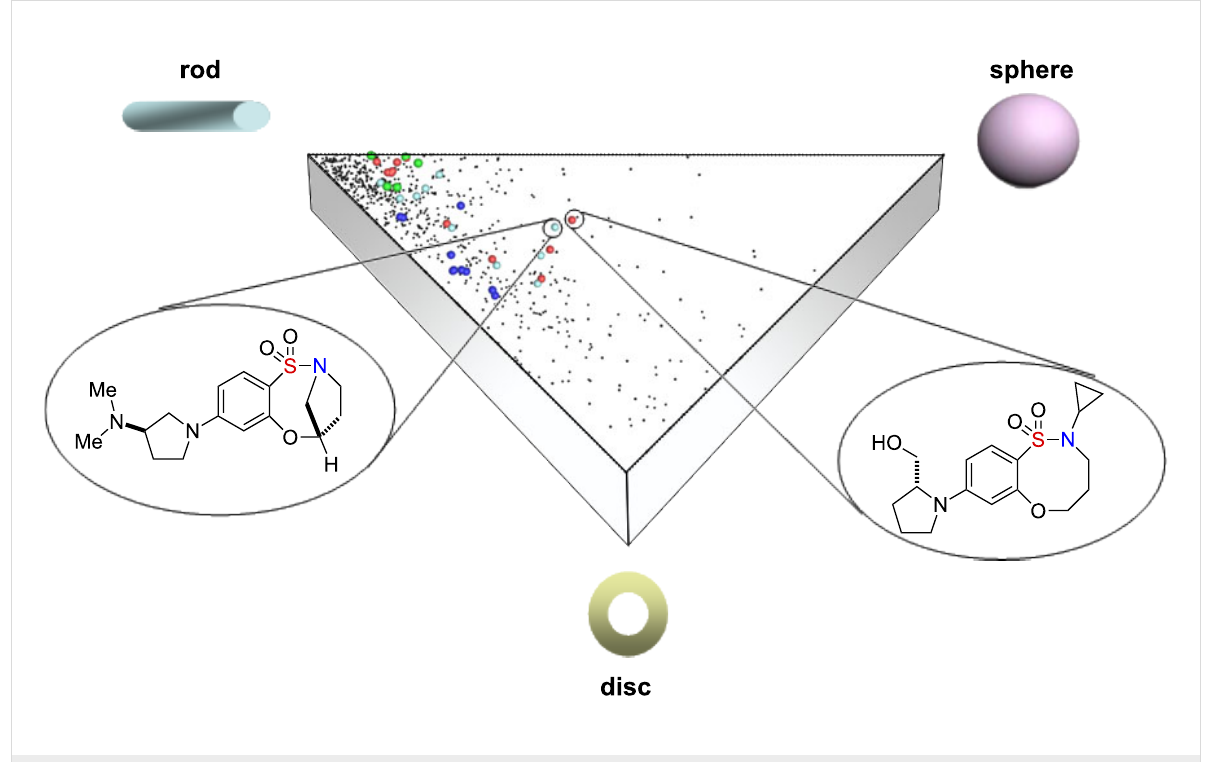
Figure 4: Distribution of 80 compounds (colored spheres) relative to the set of 771 known orally available drugs (black dots) [43].